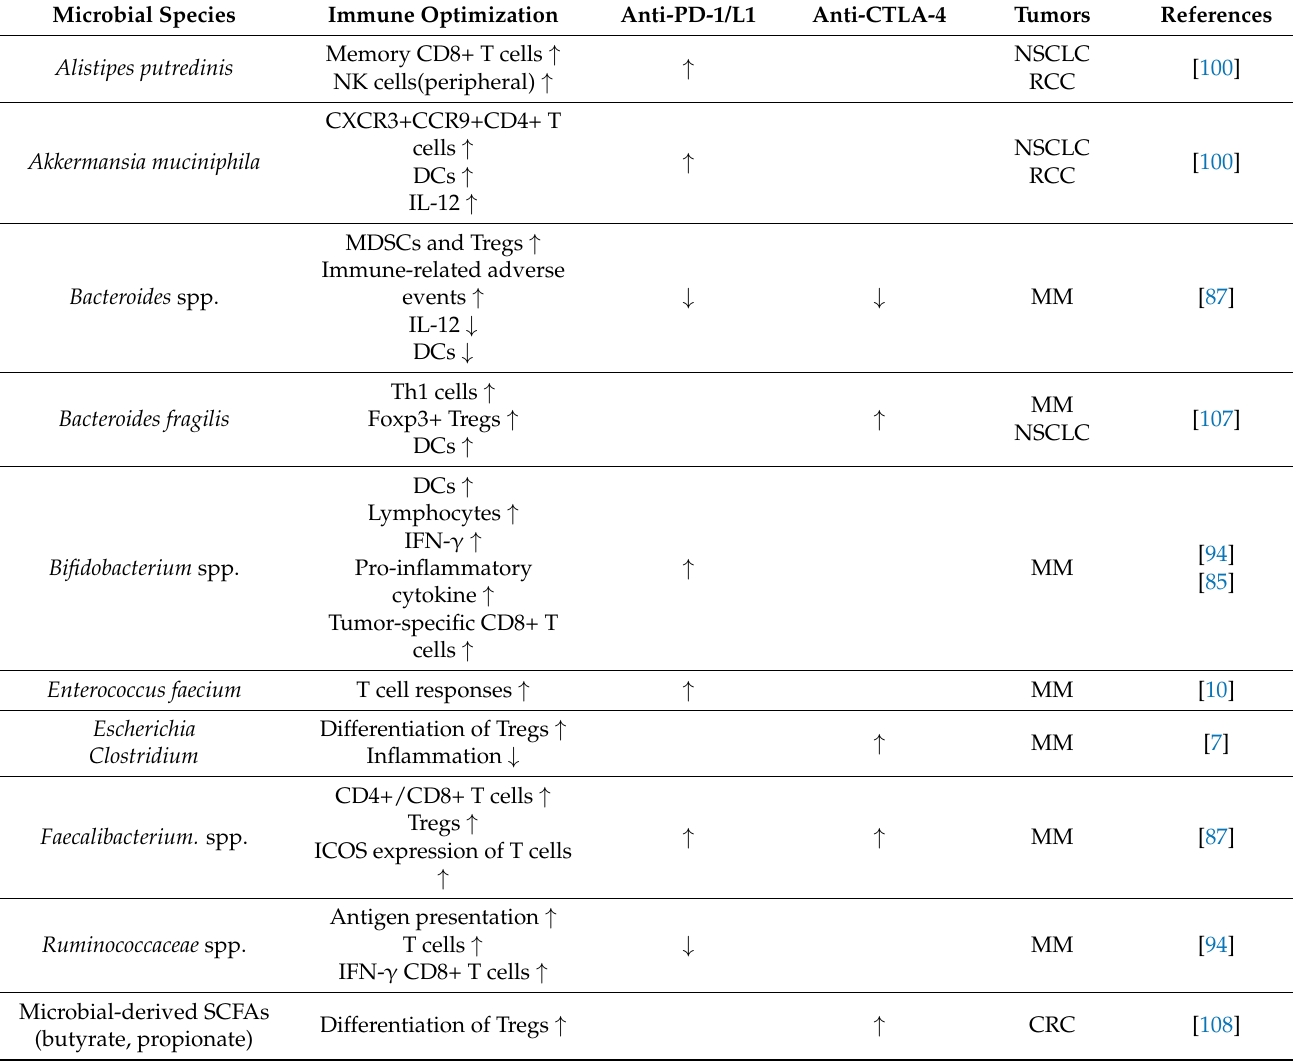
Table 3. Intestinal microbiota optimizes cancer